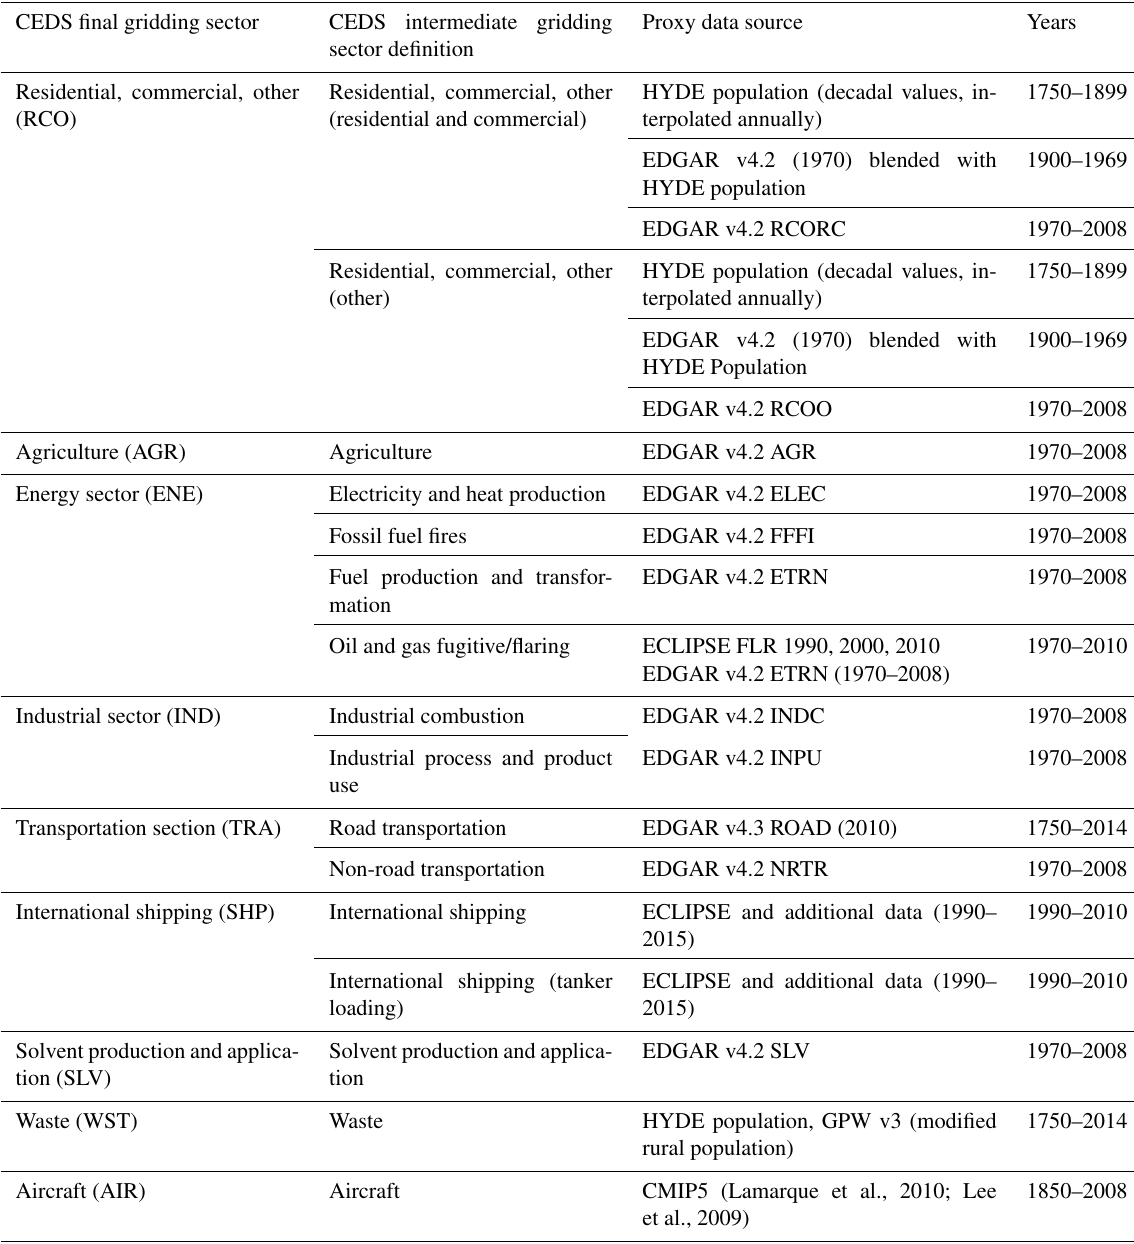
Table 6. Proxy data used for